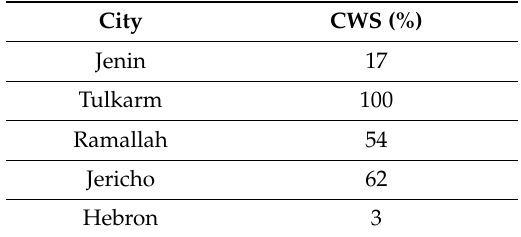
Table 17. Continuity of the water supply (CWS) in 2017.